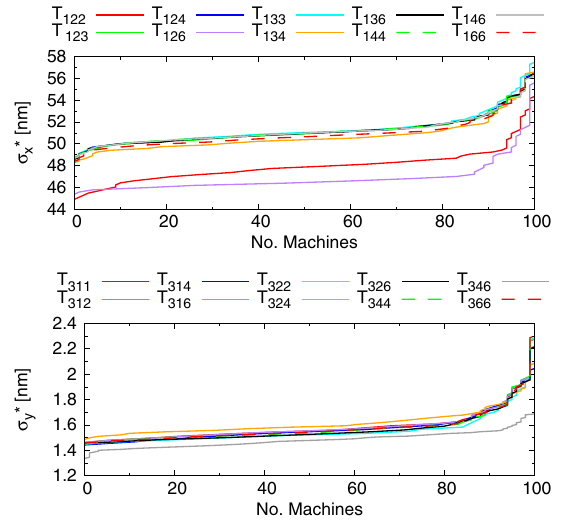
FIG. 1. Cumulative histograms over 100 IP beam distributions of σ (cid:2) x (top) and σ (cid:2) y (bottom), when the second order correlations are individually removed.